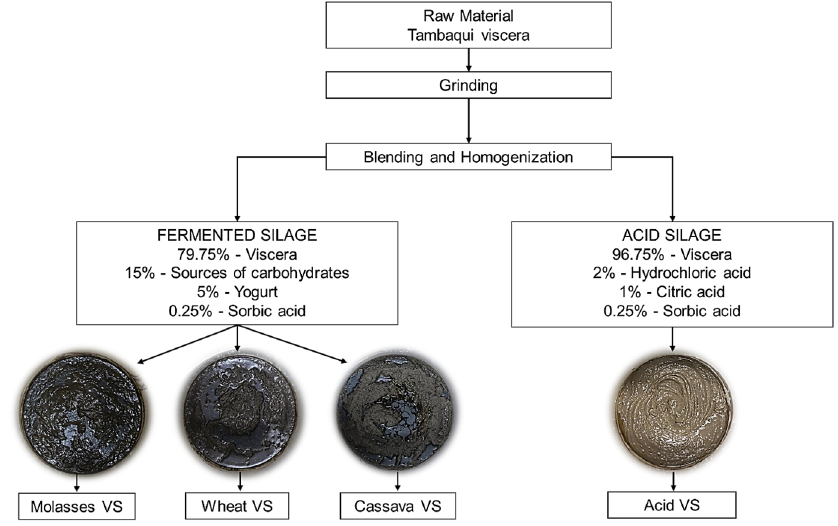
Figure 1. Flow chart of fermented and acid silage production. Molasses VS—fermented molasses silage; wheat VS—fermented wheat bran silage; cassava VS—fermented cassava waste silage; acid VS—acid silage.